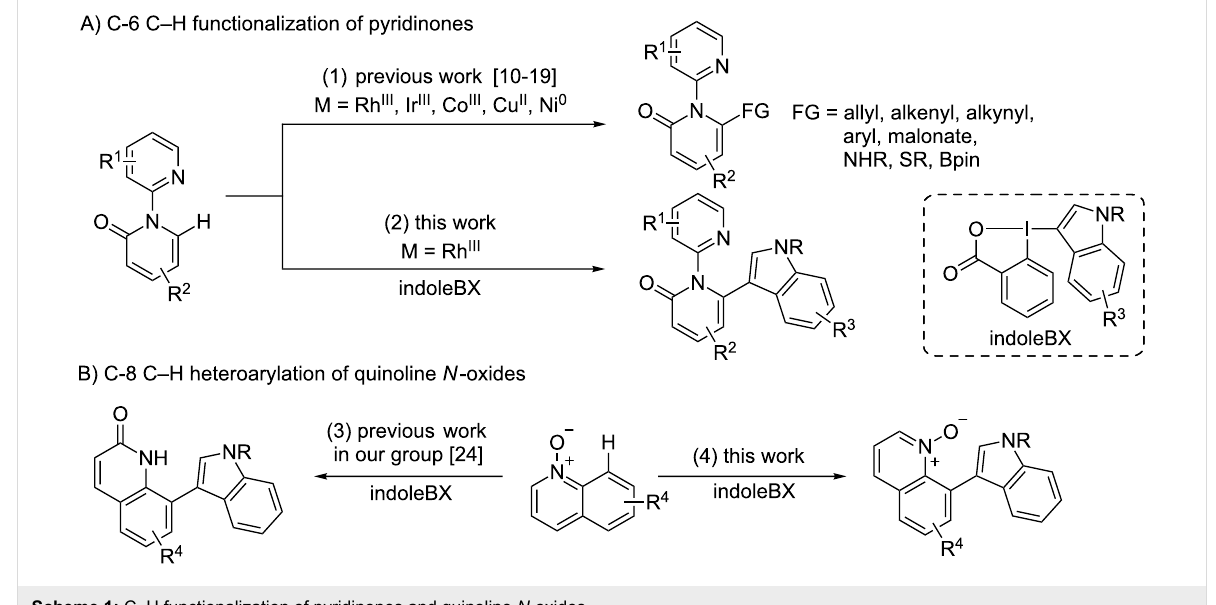
Scheme 1: C–H functionalization of pyridinones and quinoline N -oxides.